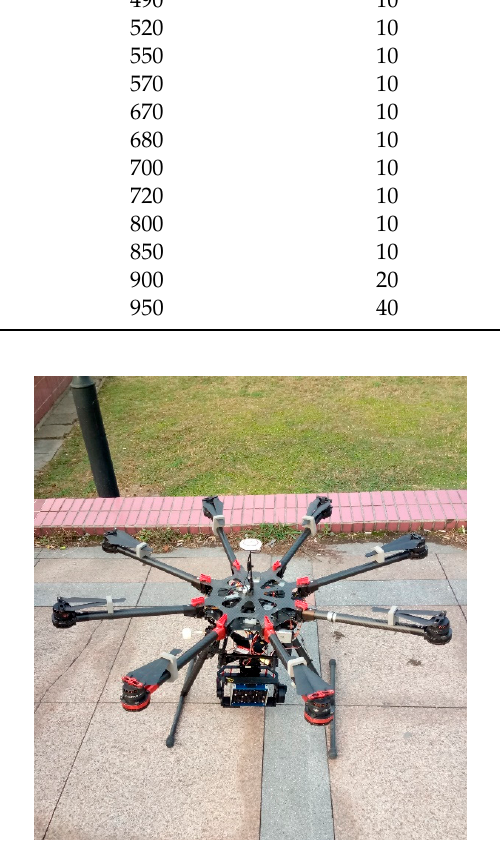
Figure 4. Spreading Wings S1000. Table 3. Characteristics of the UAV.